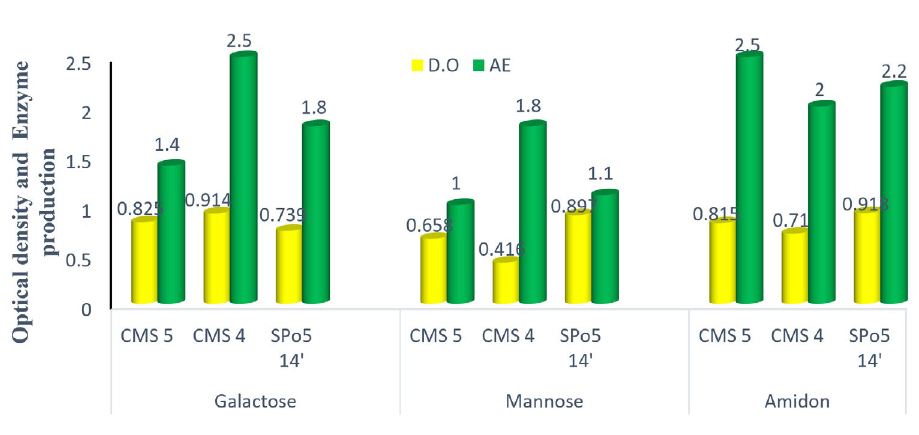
Fig. 8. The effect of carbon sources on the growth and production of three strains of Bacillus : Bacillus subtilis (CMS5), Bacillus sp. (CMS4) and Bacillus velenzensis (SPo5 14').